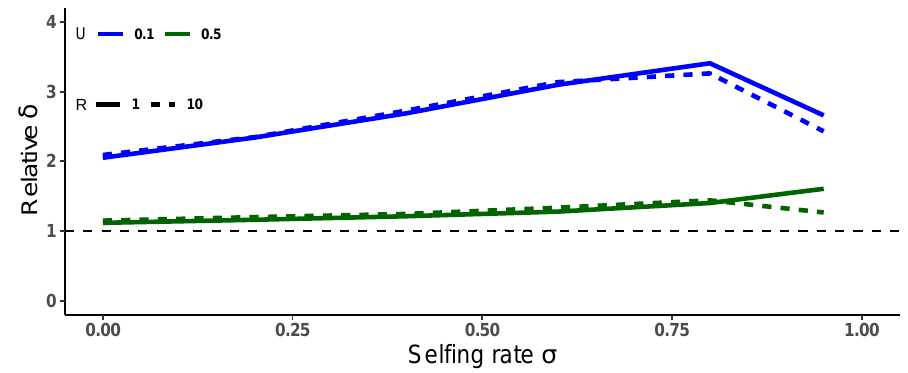
6 Morgans with mu-